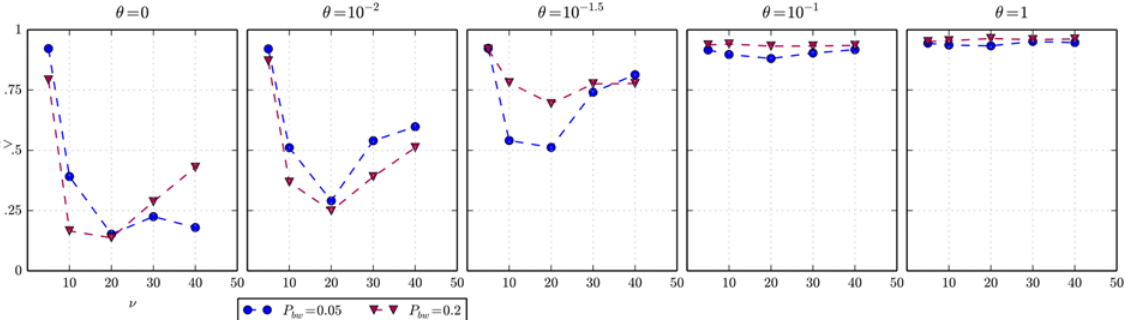
Fig 6. Average cooperation and importance of social capital. Row of plots of the average cooperation < c > as a function of vision v for different levels of importance of social capital θ , when the spatial distribution of beached whales is uniform in the space and the agents ’ movement is a random walk. The maximum standard error of the average of cooperation of all experiments represented in the plots is